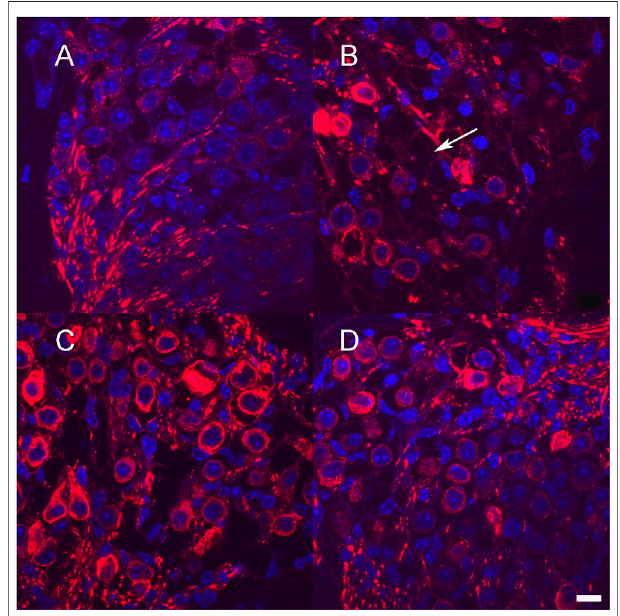
FIGURE 7 | Expression of neurotrophins and their receptors after neomycin treatment and Ad28.lat.bdnf (A,B) and Ad28.lat.nf3 (C,D) . Expression of BDNF in the damaged organ of Corti (A) . Expression of TrkB in the spiral ganglion after neomycin treatment followed by BDNF delivery demonstrating expression of the main receptor for BDNF in surviving spiral ganglion cells (B) . Expression of NT-3 in the damaged organ of Corti (C) . Expression of TrkC in the spiral ganglion after neomycin treatment (D) . Scale bar = 10